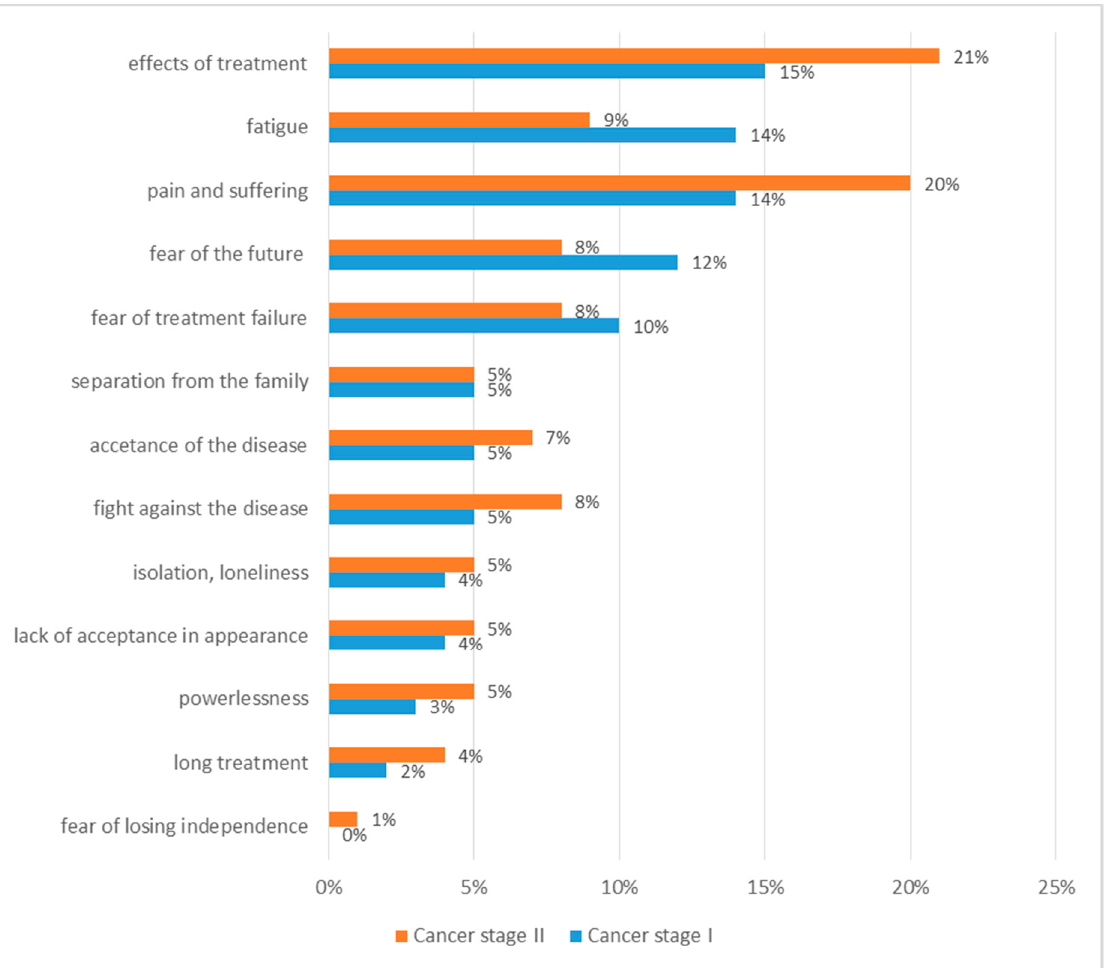
Figure 4. Most difficult aspects of the disease.